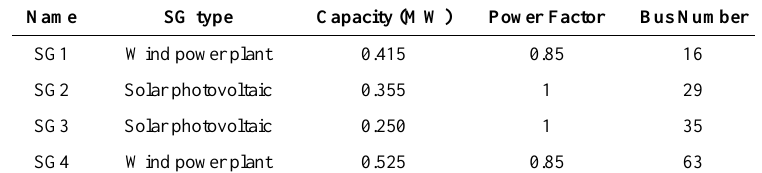
Table 4. Location and capacity of IEEE model distribution network 71-bus.